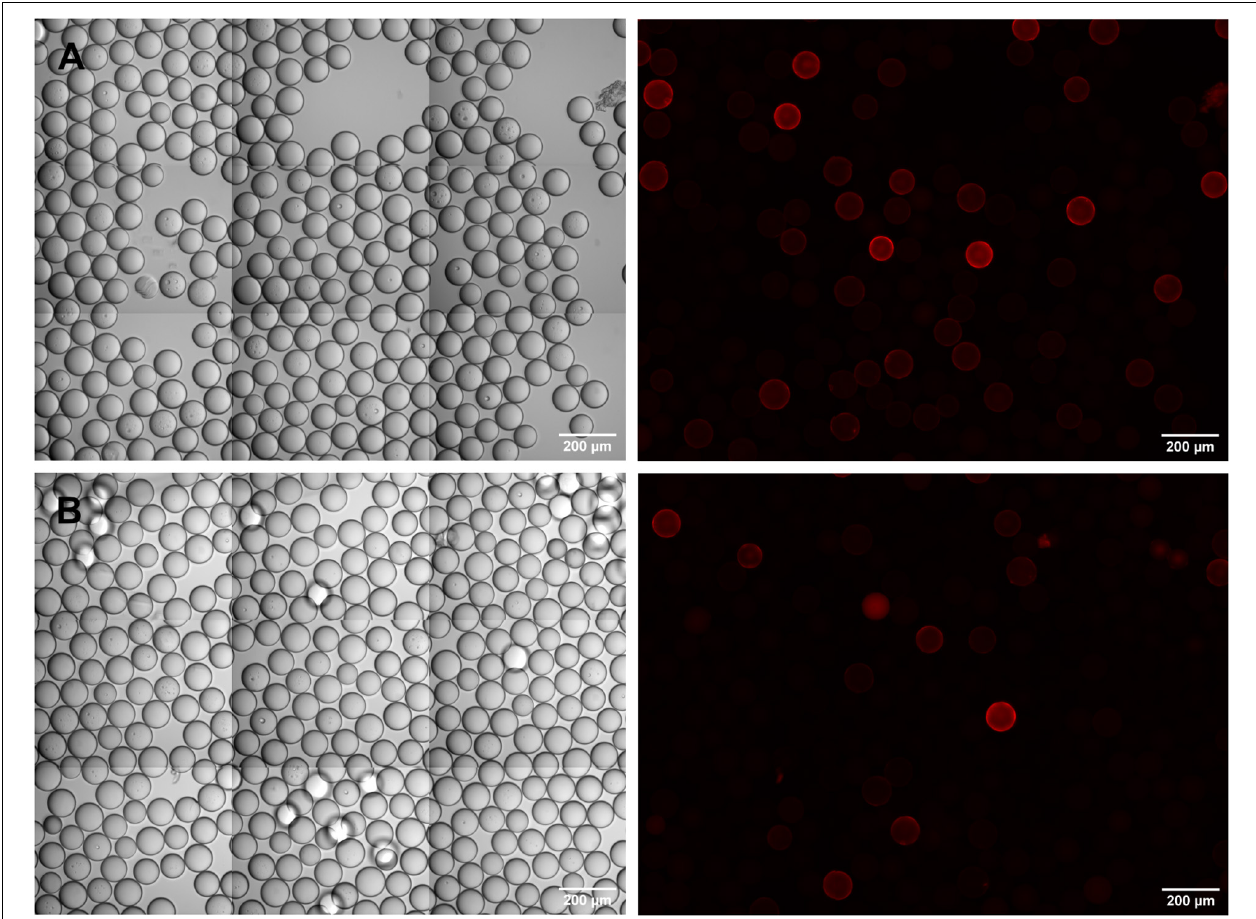
FIGURE 4 | Sporadic cross-reactivity of anti-IgE antibodies with bead-bound random peptides in an OBOC-library. (A) DyLight550-labeled, polyclonal anti-IgE antibody; (B) phycoerythrin-labeled, monoclonal anti-IgE antibody. Phase contrast images are shown on the left, corresponding fluorescence images on the right side of the